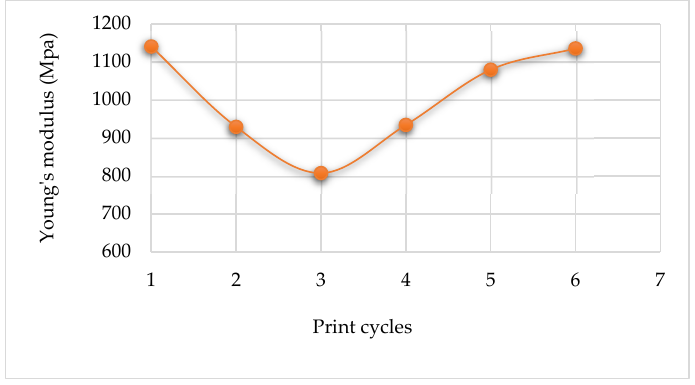
Figure 18. Young’s modulus of parts printed using Laser PP CP 75. The Young’s modulus of the printed parts decreases continuously with the re ‐ using of the powder up to the 2nd re ‐ use cycle from an initial value of 1141.273 MPa for the 1st print cycle to 807.638 MPa after the 3rd print cycle. After this, Young’s modulus starts to increase with each re ‐ use cycle.